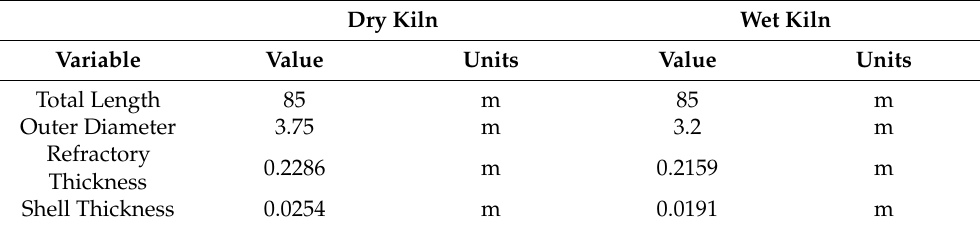
Table 1. Dry and wet kiln dimensions.